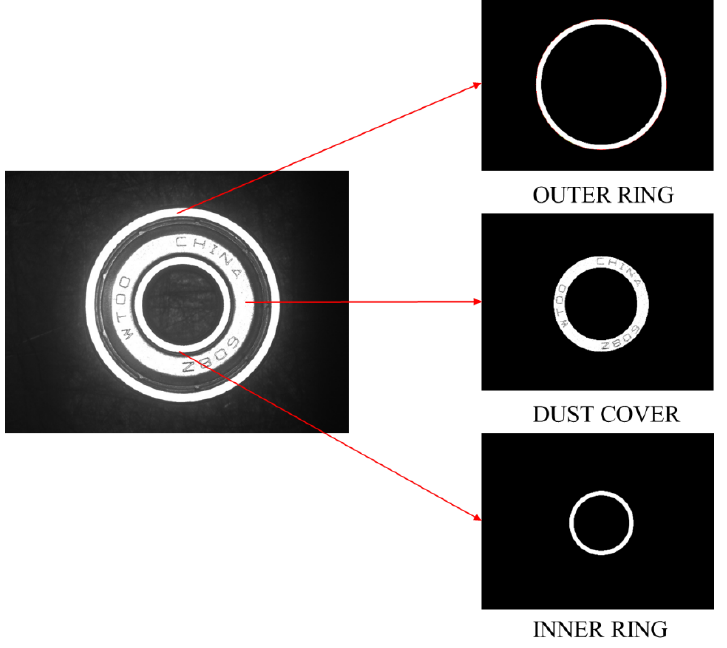
Figure 5. Segmentation of the outer ring, inner ring and dust cover of the